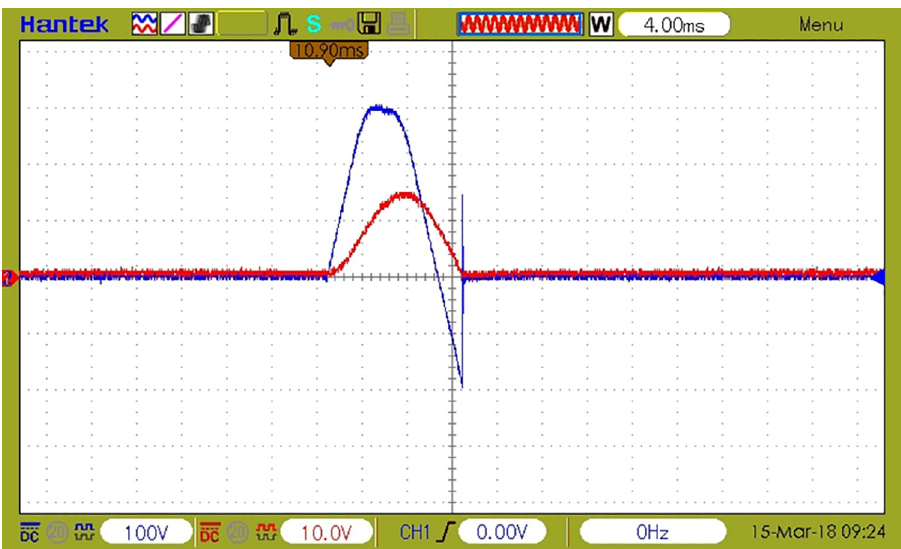
Fig 9. The waveforms of load current and voltage at coupling followed by decoupling of RL load. Decoupling time 10ms, overload 50%.